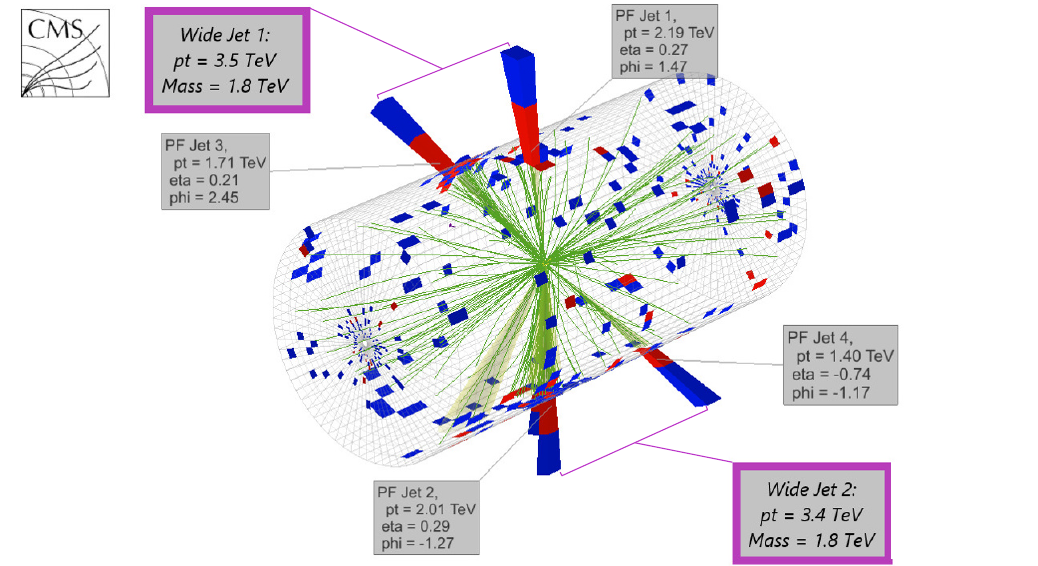
Figure 3 . Three-dimensional display of the event with the second-highest dijet invariant mass of 8 TeV. The display shows the energy deposited in the electromagnetic (red) and hadronic (blue) calorimeters and the reconstructed tracks of charged particles (green). The grouping of four ob- served jets into two wide jets (purple) is discussed in the